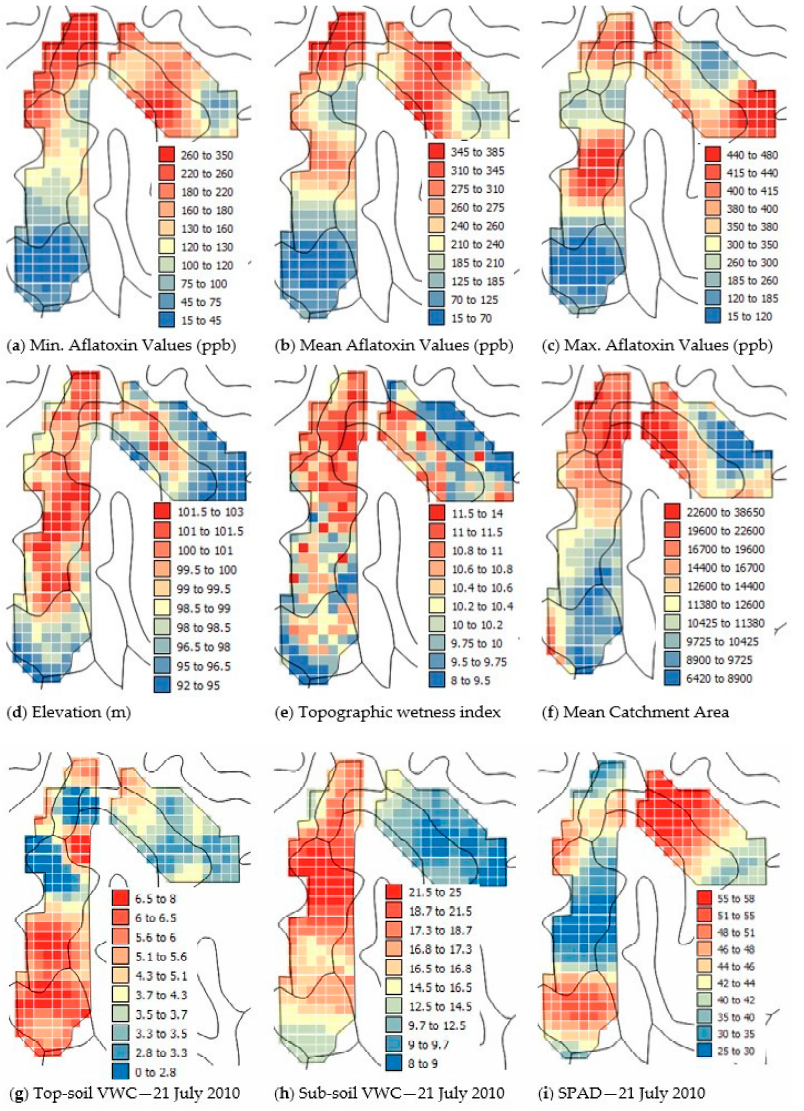
Figure 4. Pixel maps (30 m) of ( a ) minimum, ( b ) mean and ( c ) maximum kriged aflatoxin, ( d ) elevation, ( e ) topographic wetness index, ( f ) mean catchment area, ( g ) Top-soil VWC for 21 July 2010, ( h ) Sub-soil VWC for 21 July 2010 and ( i ) crop SPAD measurements for 21 July 2010. Black lines show soil series